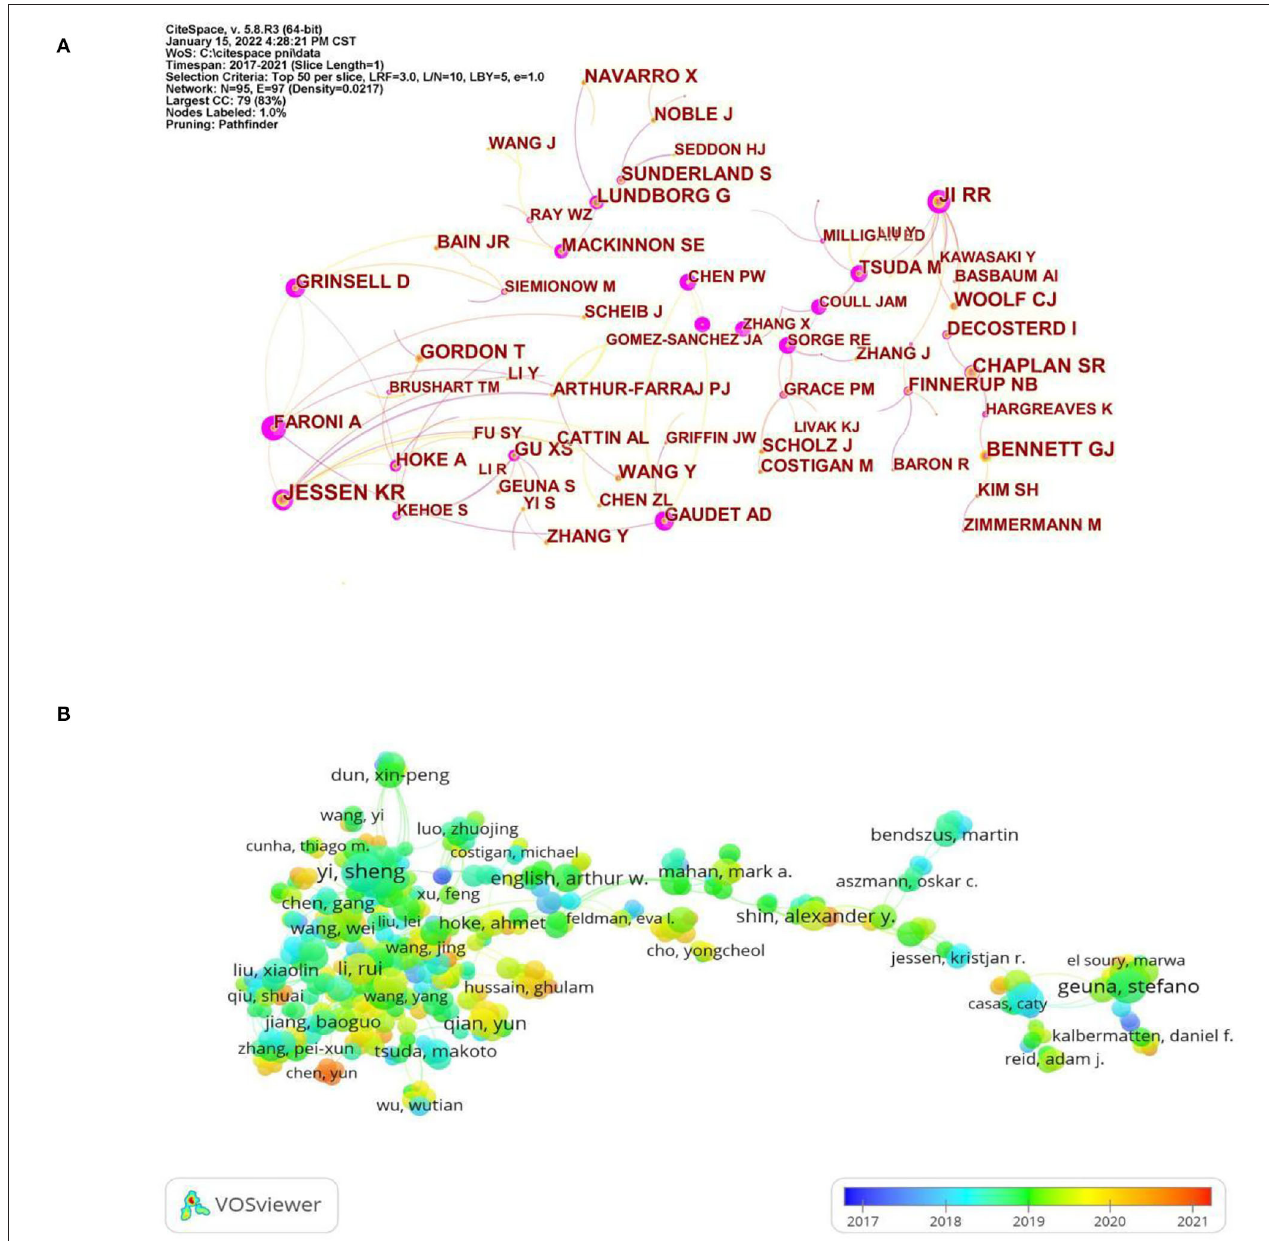
FIGURE 4 | (A) Visualization map of author co-citation analysis by using CiteSpace software. (B) Coverage visualization map of author co-authorship analysis by using VOSviewer software.